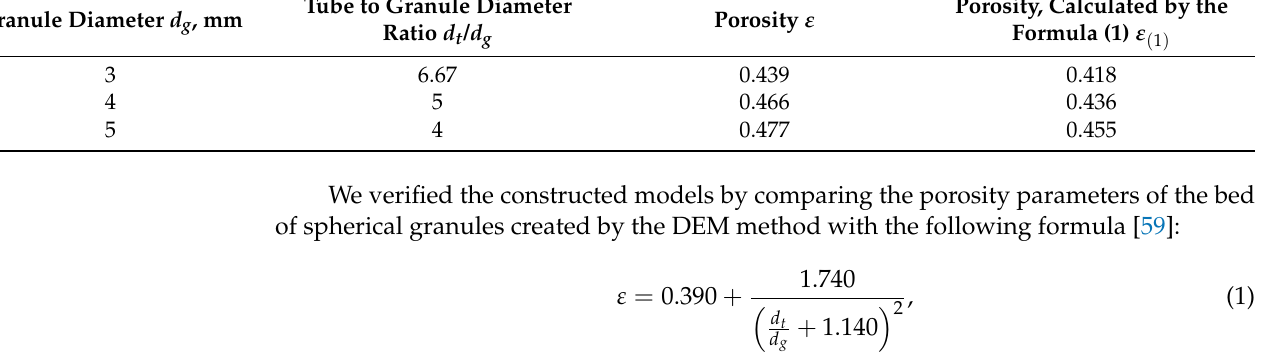
Table 1. Parameters of the spherical granule packing models used for the calculations. Tube to Granule Diameter Porosity, Calculated by the Granule Diameter d g , mm Porosity ε Ratio d t / d g Formula (1) ε ( 1 ) 3 6.67 0.439 0.418 4 5 0.466 0.436 5 4 0.477